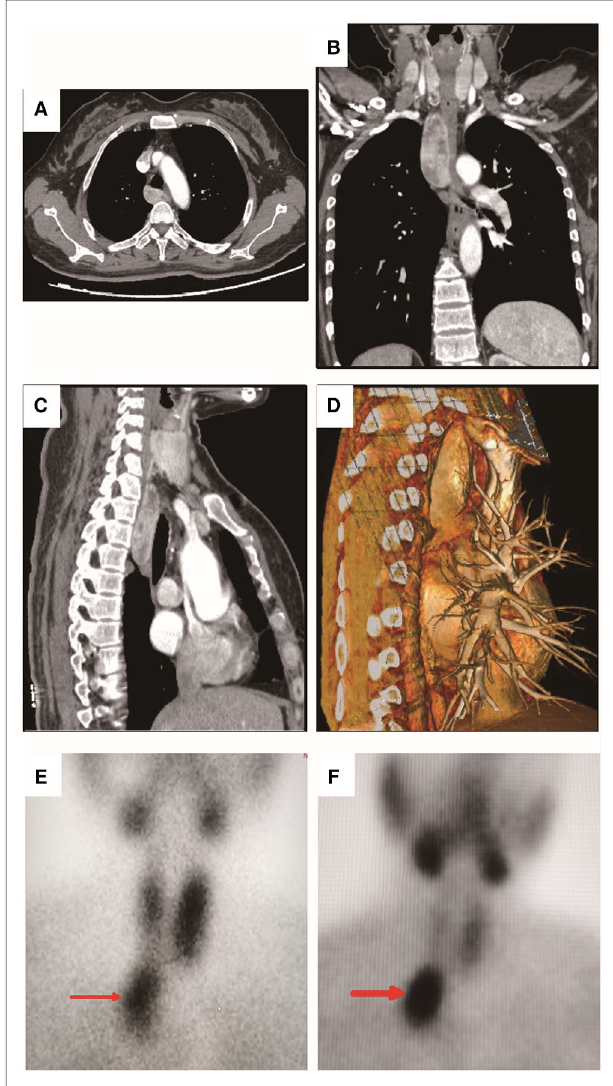
FIGURE 1 | Computed tomography (CT) scan and 99 m -Technetium sestamibi scanning of the patient. ( A ) Transverse view of the CT scanning showed a mixed density mass with uneven enhancement in the posterior mediastinum. The maximum cross-section size was about 3.3×1.9 cm.; ( B ) Coronal view of the CT scanning; ( C ) Sagittal view of the CT scanning; ( D ). Three-dimensional reconstruction in sagittal view of the CT scanning; ( E ) The 15th minute static imaging: the left thyroid lobe was more prominent, whereas the uptake of imaging agent in the right thyroid lobe was decreased; In addition, localized abnormal uptake of imaging agent under the right thyroid lobe was found (as shown by the red arrow). ( F ) The two-hour delayed imaging: the uptake of thyroid imaging was lower than that before, the abnormal imaging agent concentration under the right thyroid lobe was clearly displayed (as shown by the red arrow).